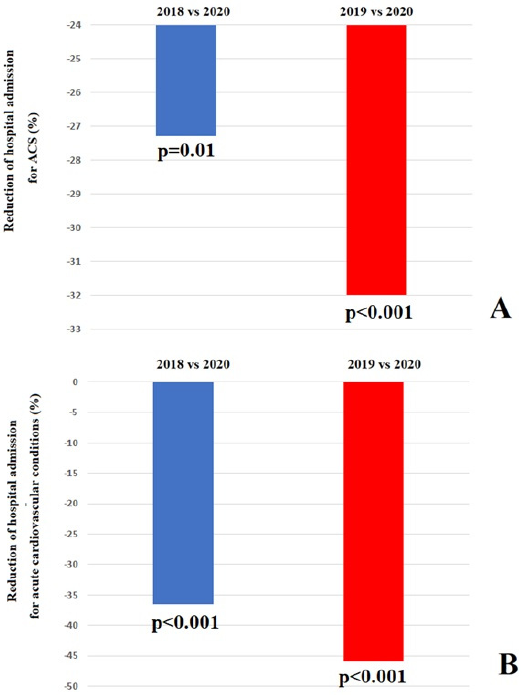
Figure 2. ( A ) Difference of hospital admission for acute coronary syndrome. ( B ) Difference of hospital admission for acute cardiovascular care. Pearson’s correlation evidenced a significant inverse relationship between the num- ber of COVID-19 cases and both ACS hospital admissions (r = − 0.881, p = 0.005) (Figure 3, Panel A) and hospitalizations for acute CV conditions (r= − 0.738, p = 0.01) (Figure 3, Panel B), respectively. This trend was mainly due to the drastic reduction in hospitalizations observed in the areas which suffered more severely by the COVID-19 spread, such as the areas around the cities of Venice, Verona and Padova.